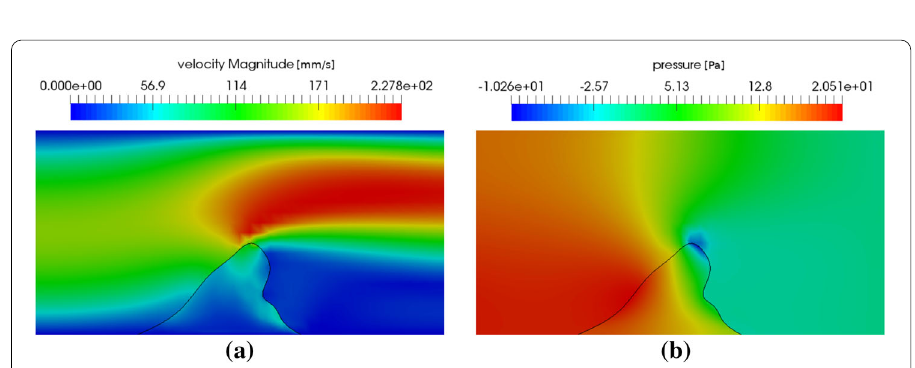
Fig. 15 Results for a fluid velocity and b fluid pressure of reference simulation illustrated on the deformed geometry both for “external” flow field and fluid inside the porous medium